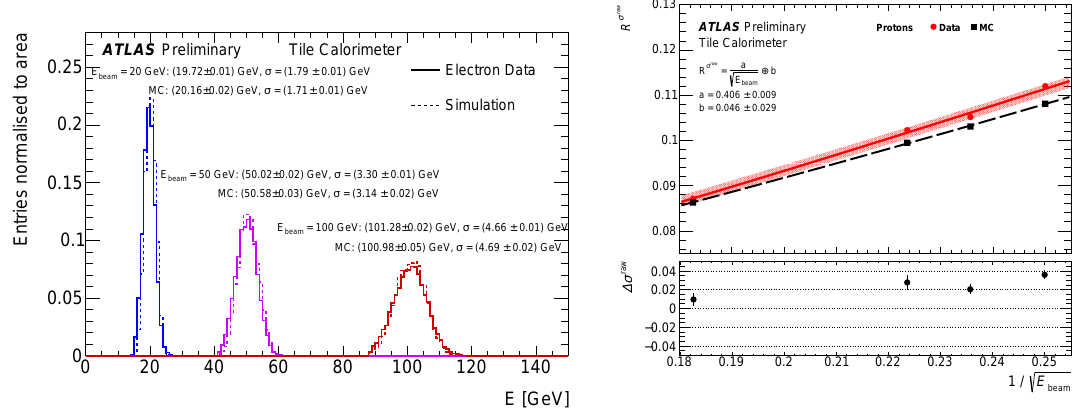
Figure 5: Distributions of the total energy deposited in the calorimeter obtained us- ing electrons beams of 20, 50 and 100 GeV incident in the cell A-4 of the middle layer of the stack at θ = 20 ◦ with respect to the beam line (Left) [ 5 ] . The fractional reso- / E lution, R σ raw = σ , measured and predicted by MC simulation as a function (cid:112) raw beam E of 1 / obtained in the case of proton beams (Right) [ 5 ] . beam